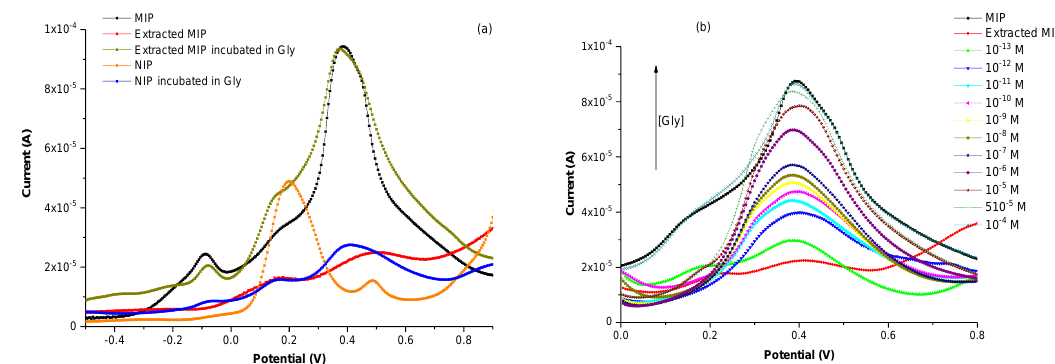
Figure 4. Square wave voltammograms of ( a ) a PPy MIP, before and after Gly extraction, a NIP, and the further extracted MIP incubated in a 10 − 4 M solution of Gly; and ( b ) a MIP-based sensor for various Gly concentrations.